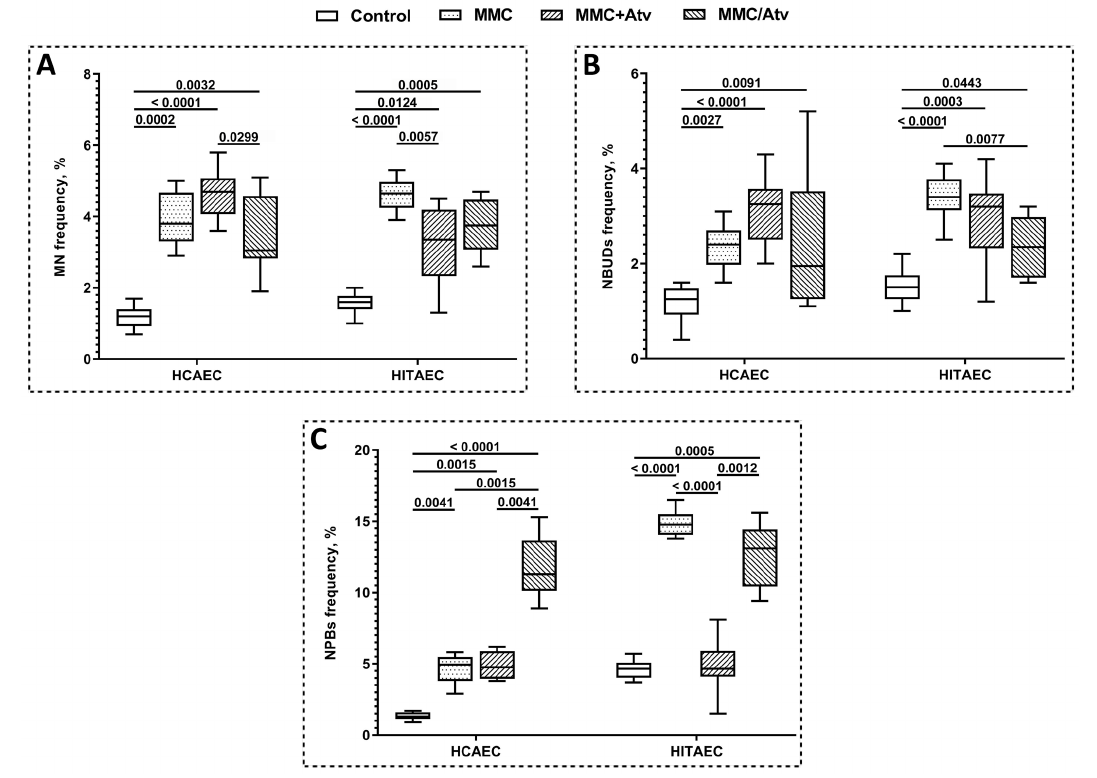
Figure 1. Frequency of MN ( A ), NBUDs ( B ), and NPBs ( C ) in endothelial cells (MMC, mitomycin C; Atv, atorvastatin; HCAEC, human coronary artery endothelial cells; HITAEC; human internal thoracic endothelial cells; MN, micronuclei; NBUDs, nuclear buds; NPBs, nucleoplasmic bridges).